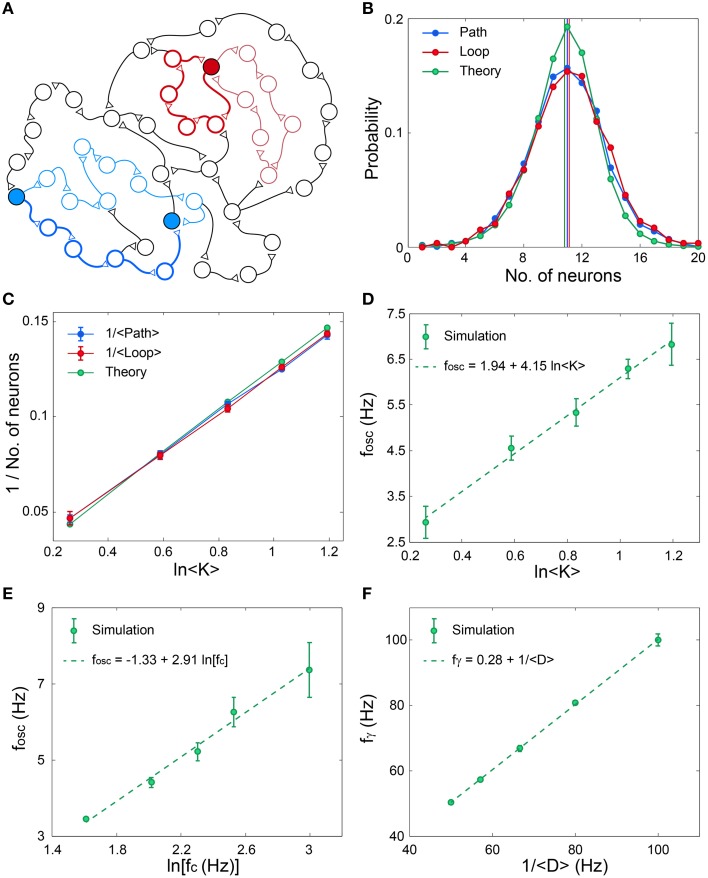
Scaling properties of fosc and fγ. (A) Schematic of an excitatory network where a self-feedback loop (light-red line) and the minimal self-feedback loop (red line) for a given neuron (filled red circle) are denoted. Similarly, a path (light-blue line) between two neurons (filled blue circles) and the minimal path (blue line) are denoted. (B) The distribution and its average (vertical lines) for the minimal path (Path) and for the minimal loop (Loop) obtained in simulations for networks as in (Figure 3A) with N = 4000, error bars are comparable with the circles. The analytical estimation is shown in green. (C) The scaling of the averaged quantities in (B) as a function of the average connectivity, < K>. (D) Simulation results indicate fosc ∝ ln < K>, where N = 4000, fc is randomly chosen for each neuron from U(5, 15) Hz and delays are randomly chosen from U(10, 15) ms. The probability for a connection between two neurons is < K>/N. Error bars indicate the standard deviation. (E) Simulation results indicate fosc ∝ln(fc), for networks as in (D), with < K> = 2, but fc is the same for all neurons. (F) Simulation results indicate fγ ∝ 1/ < D>, for networks as in (D), with < K> = 2, but delays are randomly chosen from U(< D> −2.5, < D>+ 2.5) ms.